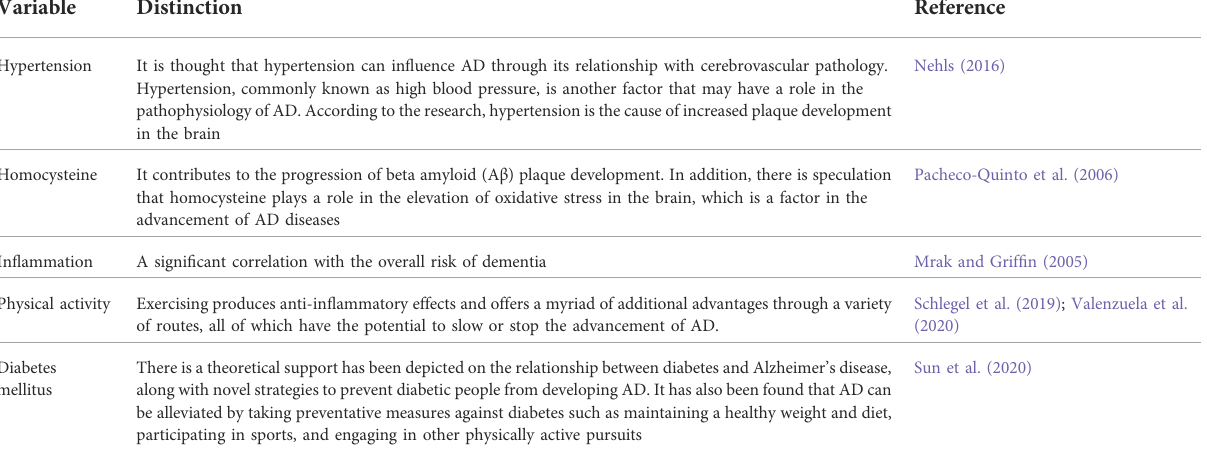
TABLE 1 The involvement of physiological factors in AD